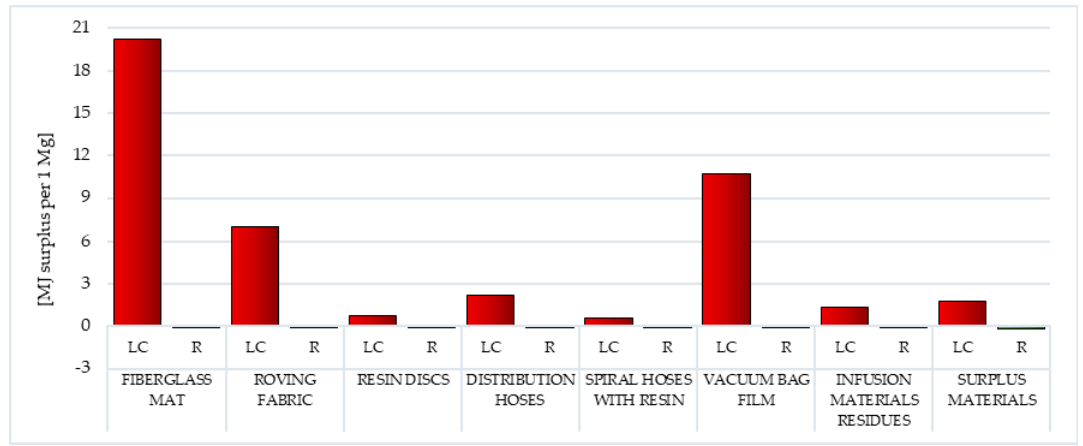
Figure 13. Characterization results of environmental consequences for processes related to the extraction of mineral resources present in selected postproduction waste of wind power plant blades: cycle, R—recycling [unit: MJ surplus per 1 LC—life cycle, R—recycling [unit: MJ surplus per 1 mg].